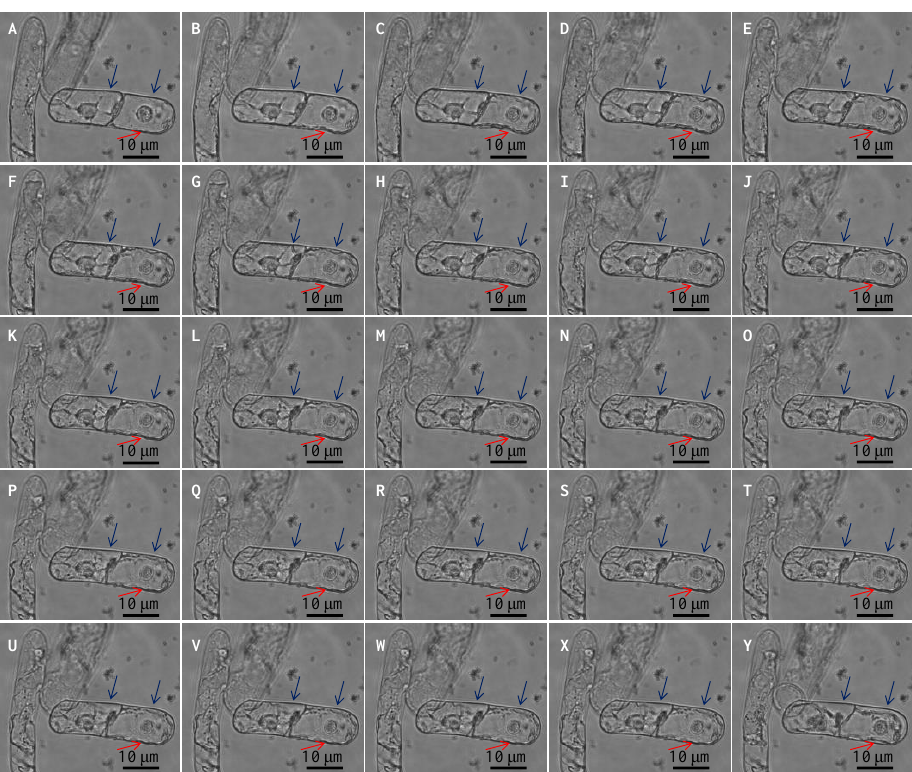
Figure 6. Morphological changes of BY-2 cells at the moment of osmotic pressure change. ( A ): Morphology of BY-2 cells in isosmotic solution before adding hypertonic solution. ( B – X ): Morphologies of BY-2 cells at intervals of 30 s after 1 M mannitol solution was added and the concentration of the solution changed to 0.4 M. ( Y ): Morphology of BY-2 cells at about 30 min after 1 M mannitol solution was added and the concentration of the solution changed to 0.4 M.